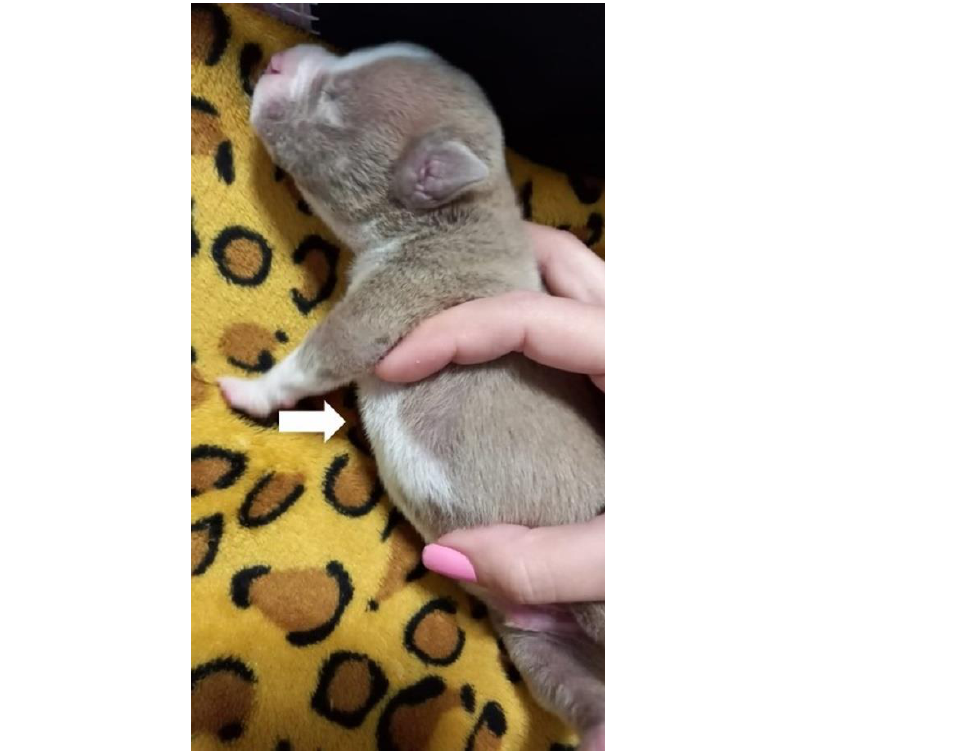
Figure 13. Patient after splint removal. Thorax presenting absence of ventrodorsal narrowing in the sternal region (arrow) after noninvasive treatment.